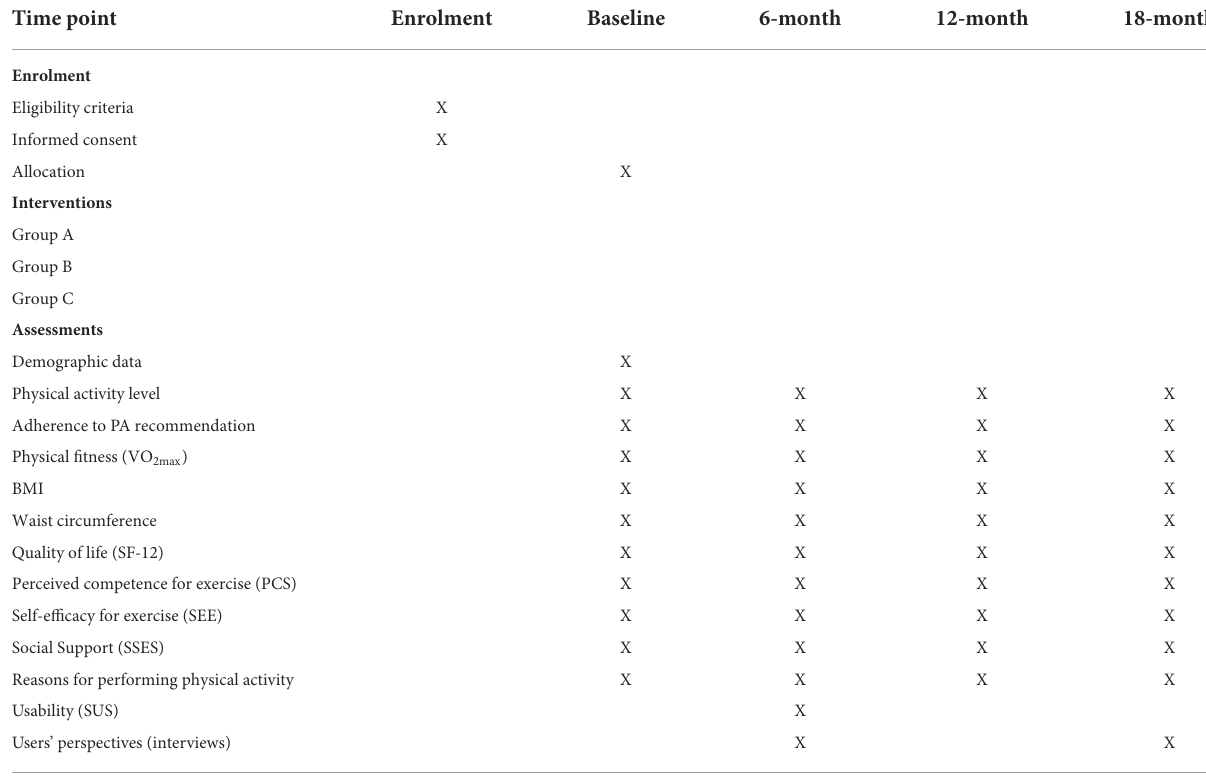
TABLE 1 Schedule of enrolment, interventions, and